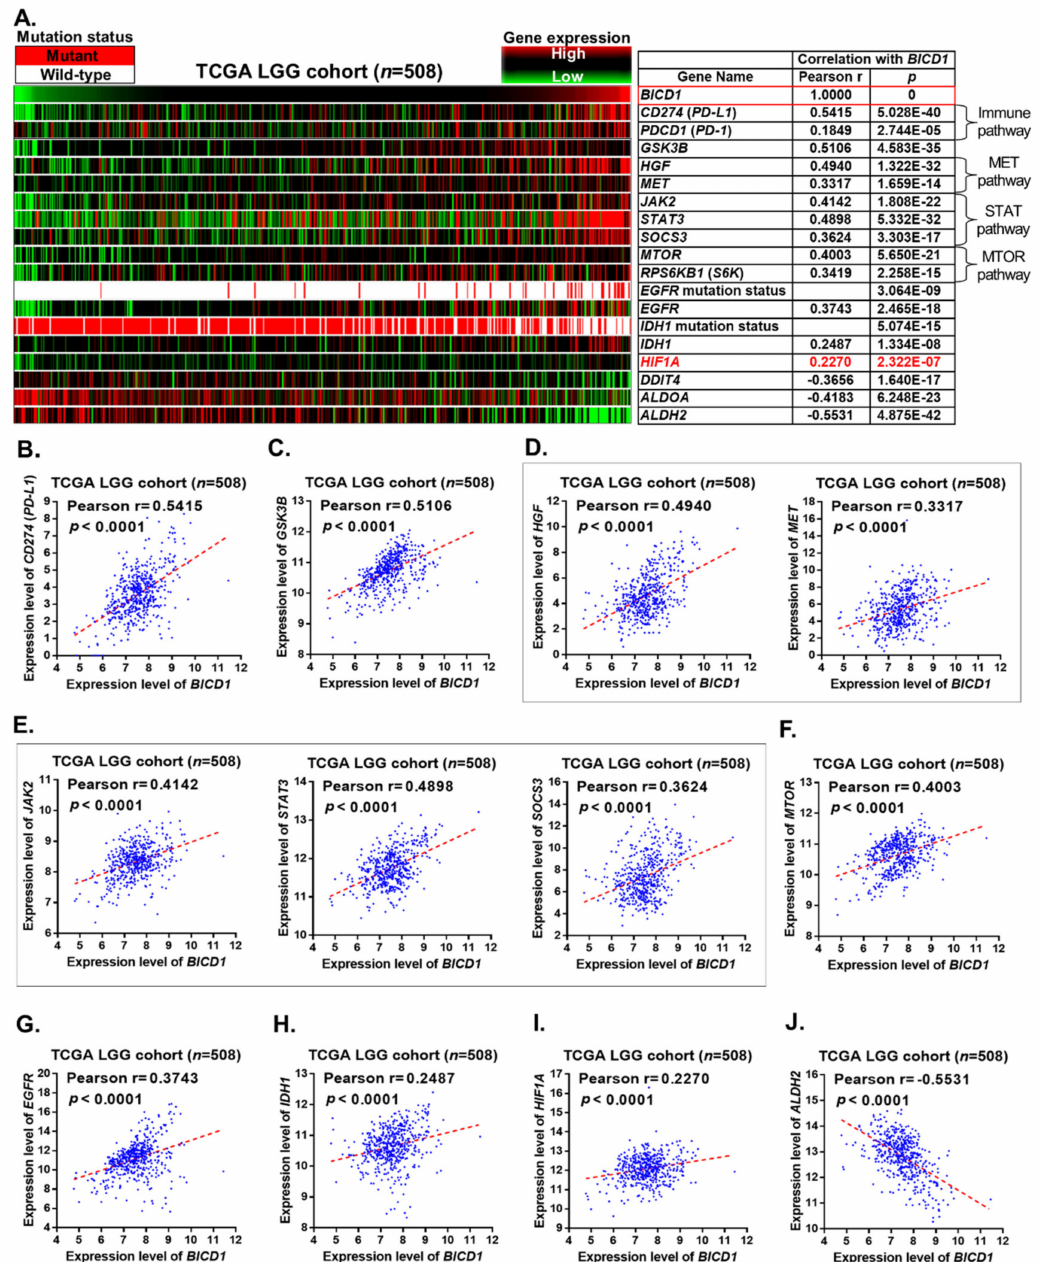
Figure 6. The correlations of BICD1 downregulation with the well-known pathways associated with cancer progression. ( A ). The heatmap revealed the correlations of BICD1 downregulation with the expression status of a couple of markers involved in various pathways associated with cancer progression in the TCGA LGG cohort. ( B ). Pearson’s correlation analysis revealed the correlation between the expression levels of BICD1 and those of CD274 (PD-L1). ( C ). The correlation between BICD1 expression and GSK3B expression. ( D ). The correlations of BICD1 expression with HGF expression and MET expression. ( E ). The correlations of BICD1 expression with JAK2 expression, STAT3 expression, and SOCS3 expression. ( F ). The correlation between BICD1 expression and MTOR expression. ( G ). The correlation between BICD1 expression and EGFR expression. ( H ). The correlation between BICD1 expression and IDH1 expression. ( I ). The correlation between BICD1 expression and HIF1A expression. ( J ). The correlation between BICD1 expression and ALDH2